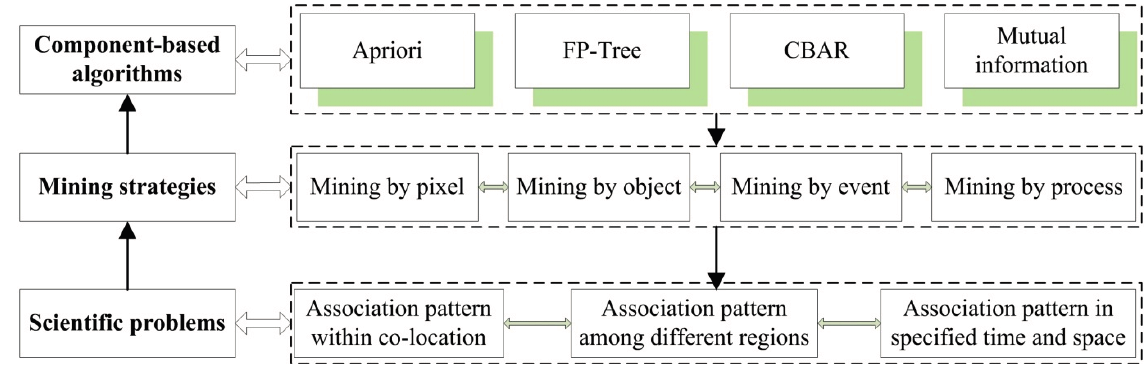
Figure 4. Workflow of the pattern mining